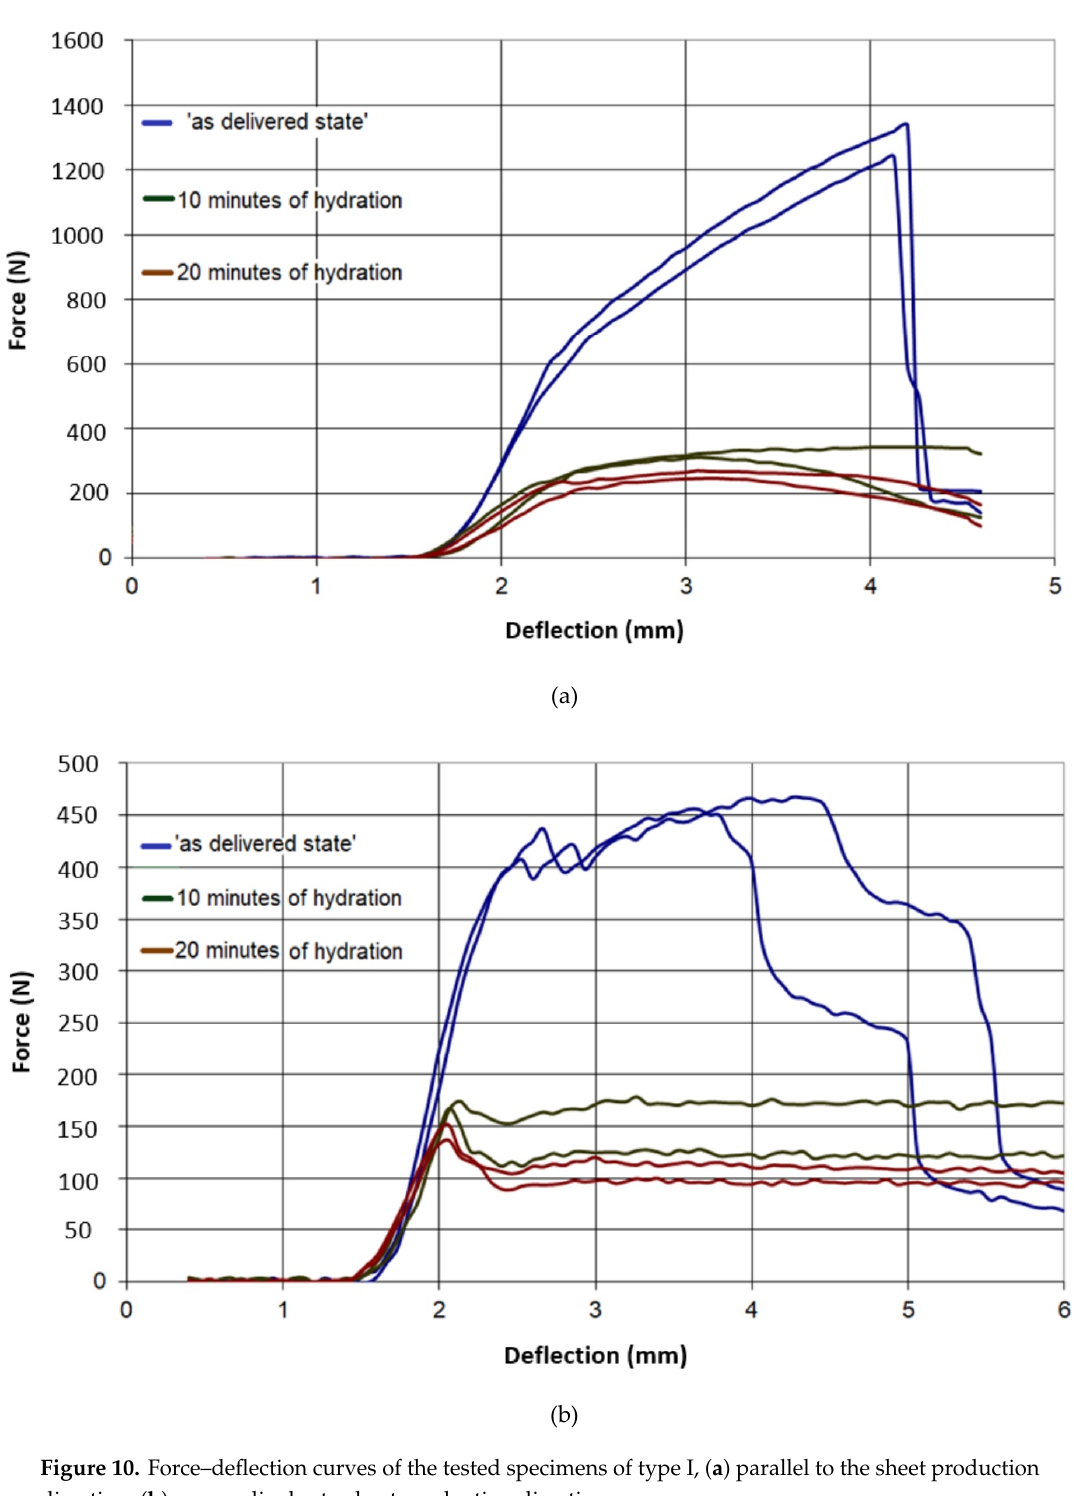
Figure 10. Force –deflection curves of the tested specimens of type I, ( a ) parallel to the sheet production direction, ( b ) perpendicular to sheet production direction.